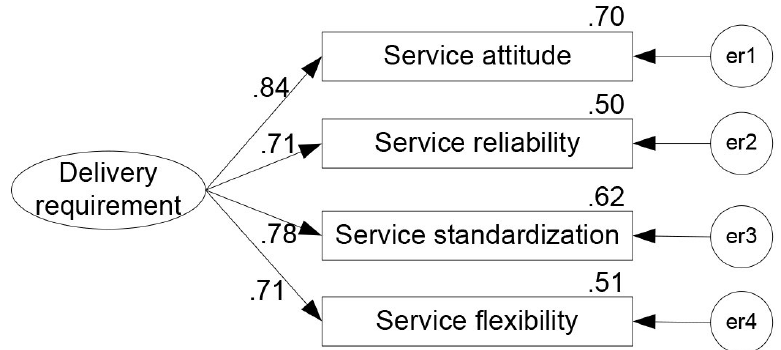
Figure 1. Delivery service requirement of confirmatory factor